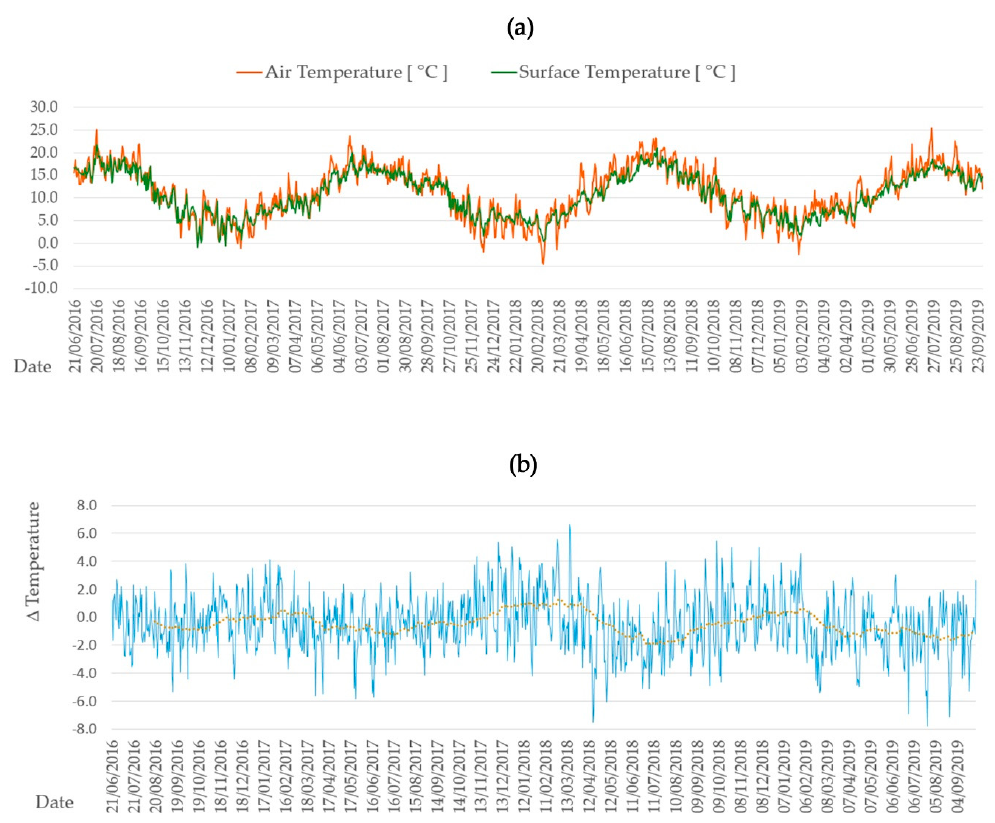
Figure 8. ( a ) Surface water temperature (°C) and air temperature (°C) registered during the monitoring period; ( b ) temperature variation between the surface and the